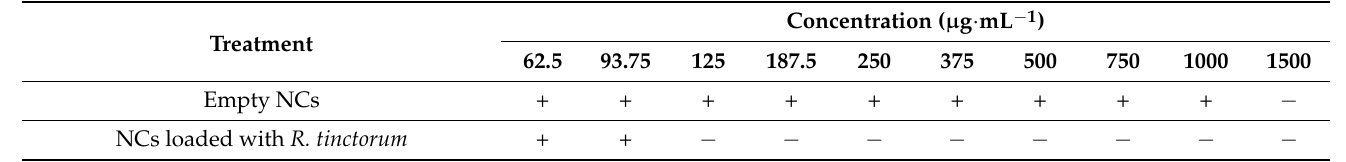
Table 2. Antibacterial activity of the g-C 3 N 4 -MA-COS nanocarriers (NCs), before and after the